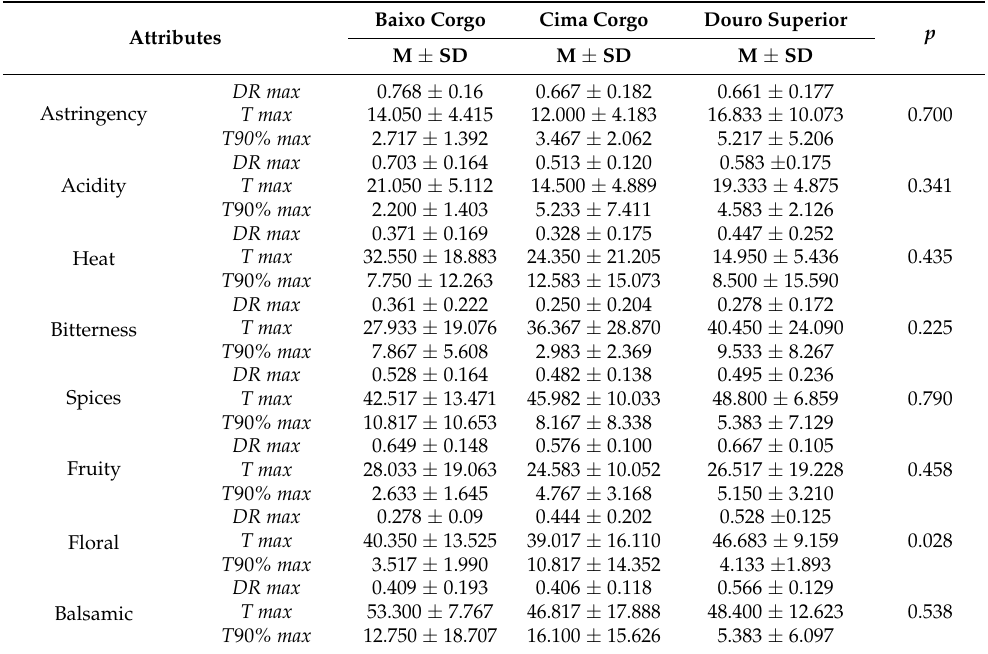
Table 10. Mean (M), standard deviation (SD), and multivariate significance of the TDS parameters— Taste/flavor